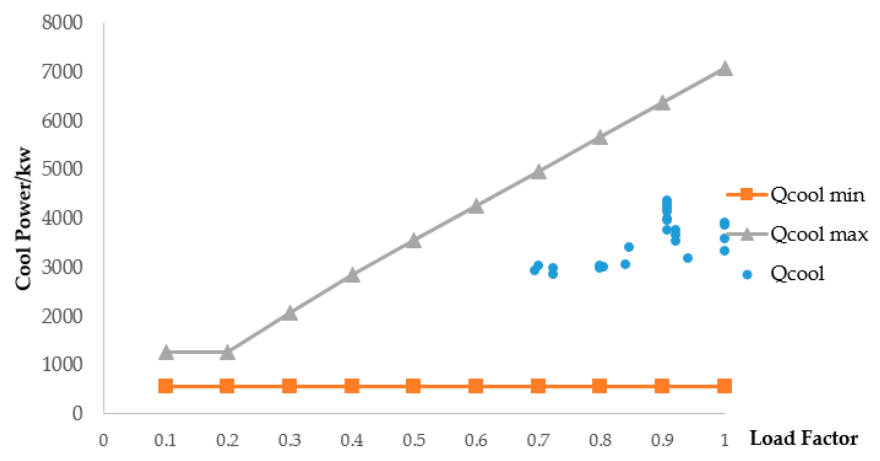
Figure 19. Single time scale cooling load-load rate operation.